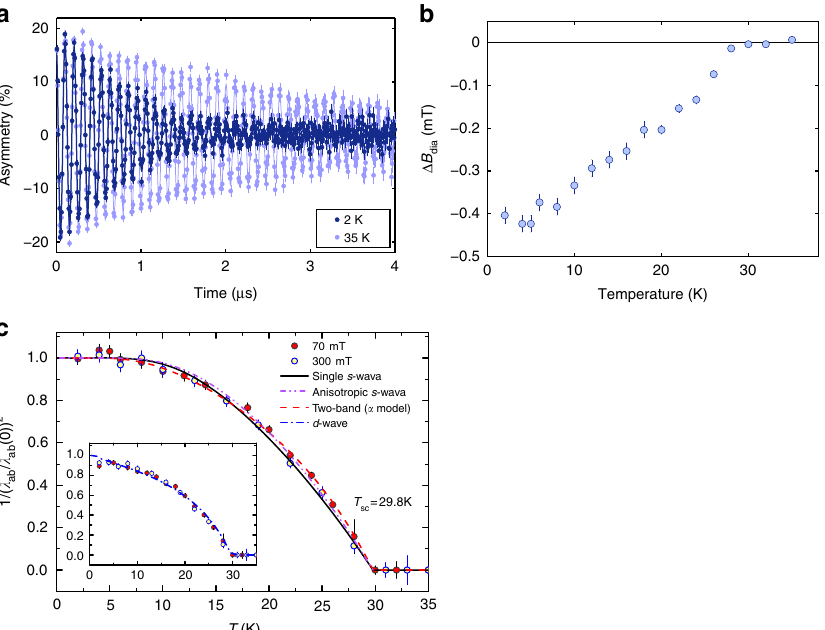
Fig. 3 TF- μ SR spectra, diamagnetic shift, and relaxation rate. a Representative TF- μ SR spectra above and below T c measured in 70 mT and relevant fi ts. b Diamagnetic fi eld-shifts in the superconducting phase. c Temperature dependence of λ − 2 , as calculated from the measured TF relaxation rate σ sc ( T ) at 70 mT ( red ) and 300 mT ( yellow ). Lines represent fi ts using a single-gap ( solid ) and two-gap or anisotropic s -wave model ( dashed ), the latter two showing a better χ 2 . The inset shows a fi t using a d -wave r